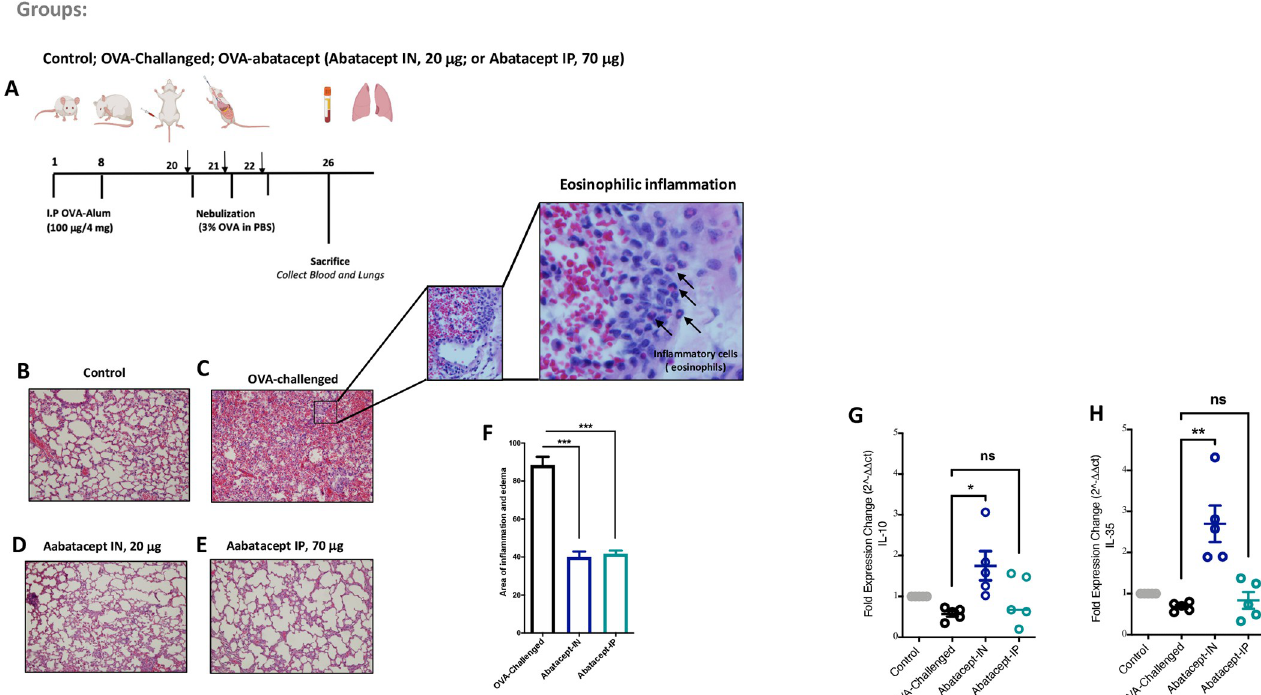
Fig 1. Abatacept attenuates acute lung tissues inflammation induced by OVA-challenge. (A) Schematic representation of the experimental procedure. Mice were sensitized with two intraperitoneal injections of ovalbumin (OVA) or PBS in an alum adjuvant at days 1 and 8. The mice received 20 μ g of abatacept intranasally (IN), 70 μ g of abatacept intraperitoneally (IP), or not, before the 3% OVA nebulizer challenge on the day 20, 21, and 22. (B-F) Lung sections were stained with haematoxylin and eosin (H&E) to measure the numbers of infiltrated inflammatory cells after the OVA-challenge, and with abatacept IN or with abatacept IP. Data shows that abatacept IN or IP attenuated acute lung tissues inflammation induced by OVA-challenge. (G and H) gene expression levels of IL-10 and IL-35 in the lung tissues of abatacept IN, abatacept IP treated, or OVA challenged mice. Data show an increase in IL-10 and IL-35 gene expression levels in the lung tissues following treatment with abatacept IN. n = 5 mice. Two-way comparison was done using t-test. ns: non-significant. � P < 0.05, �� P < 0.01, ��� P < 0.001.